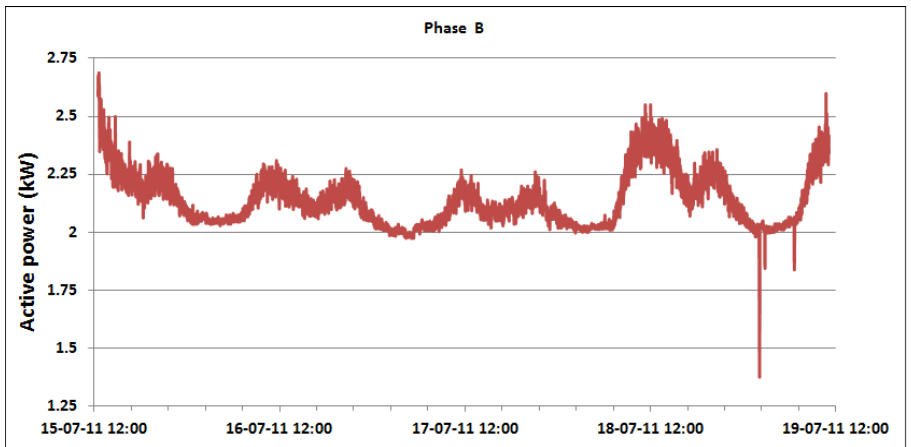
Figure 14. Active power of phase B for 15–19